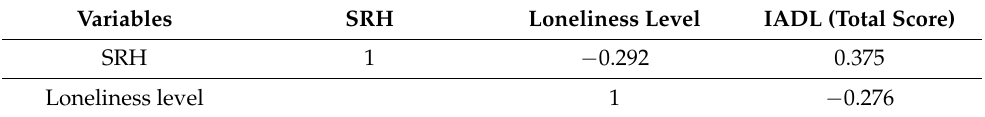
Table 5. The Spearman correlation coefficients ( r ) among SRH, loneliness level, and IADL (total score).